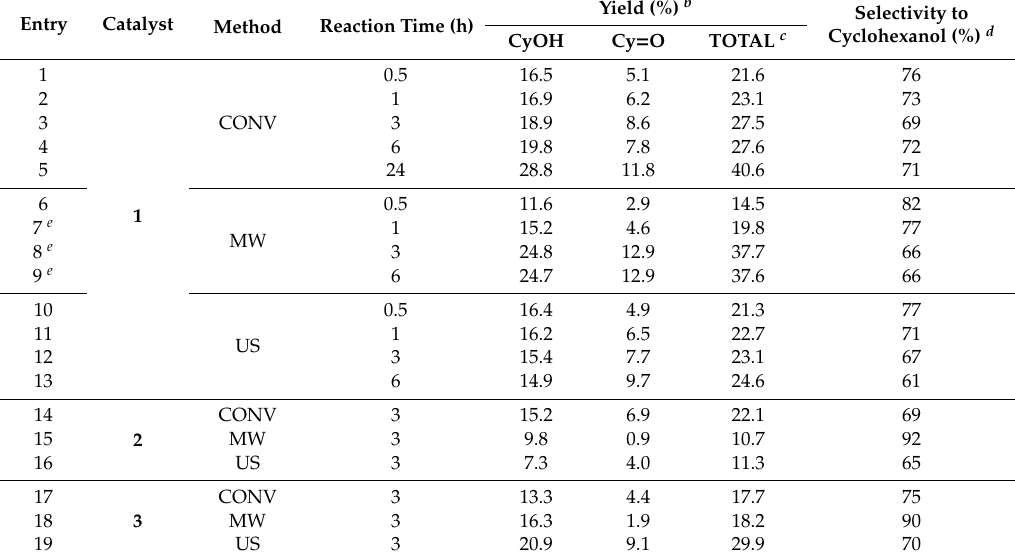
Table 3. E ff ect of di ff erent energy inputs for the oxidation of cyclohexane by catalysts 1 - 3 using TBHP (70% aq.) as an oxidant a